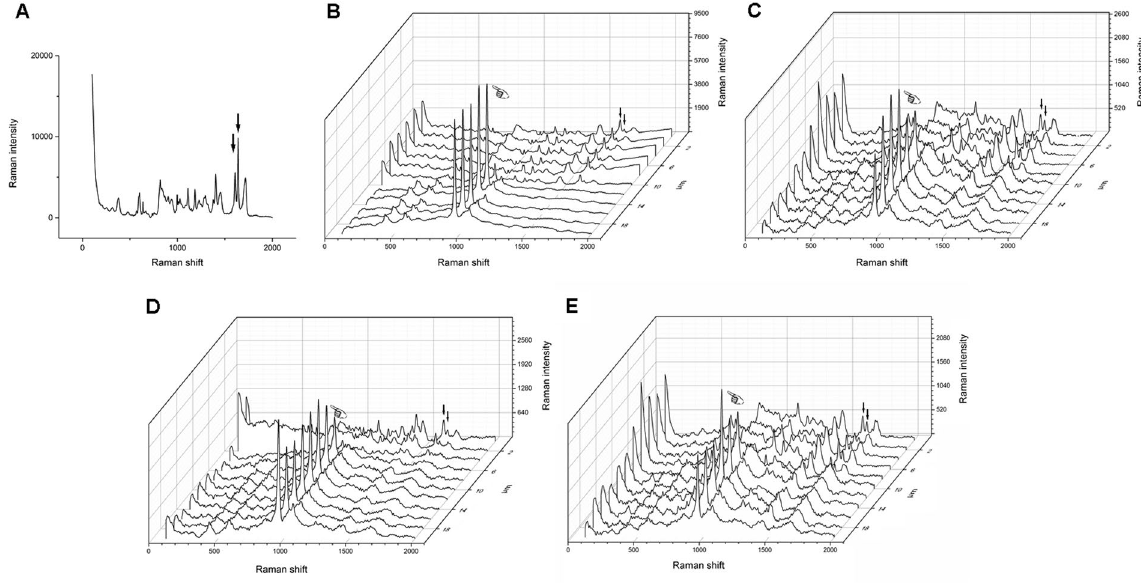
Figure 1. Micro-Raman spectrum acquired with CSB. ( A ) The representive spectrum of uncured CSB. The representive spectrum acquired across the adhesive–dentine interface produced by cured CSB of three groups: B-BC Group; C-NA Group; D, NEG Group; E, NE Group. In all figures, the first spectrum was collected in mineralized dentine: the finger indicated the PO 43 − group. The simultaneous decrease in the phosphate peak and increases in the adhesive peaks at 1608 cm − 1 and at 1640 cm − 1 (arrows) suggested the beginning of the hybrid layer.